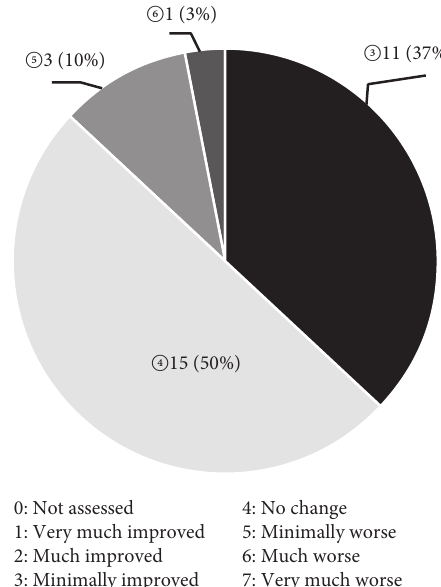
Figure 4: The CGI-I scale in the post-RTP group was minimally improved in 29%, not changed in 50%, minimally worse in 11%, and much worse in 1% relative to